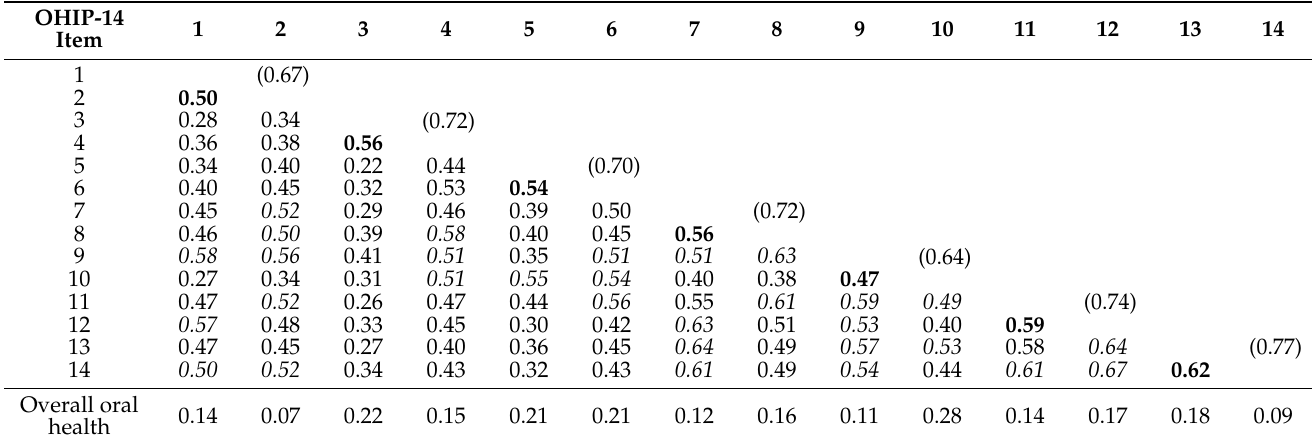
Table 3. OHIP-14 in the study participants: Cronbach’s alpha of the original 7 dimensions, and Spearman correlation matrix of the 14 items and the overall